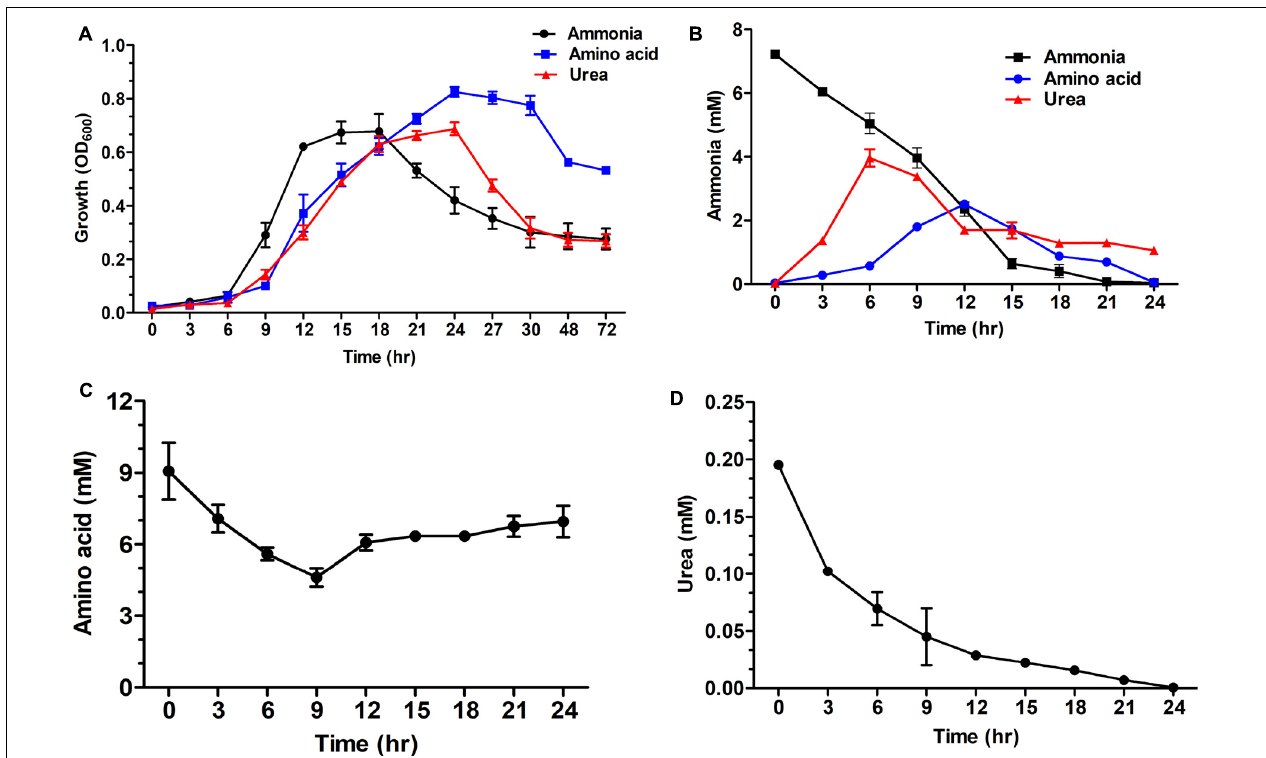
FIGURE 6 | Time course measurements of the effect of nitrogen sources on growth of S. dextrinosolvens Z6. Data points represent averages for triplicate cultures. Error bars represent standard deviations. (A) Growth. (B) Ammonia utilization and production. (C) Amino acid utilization. (D) Urea